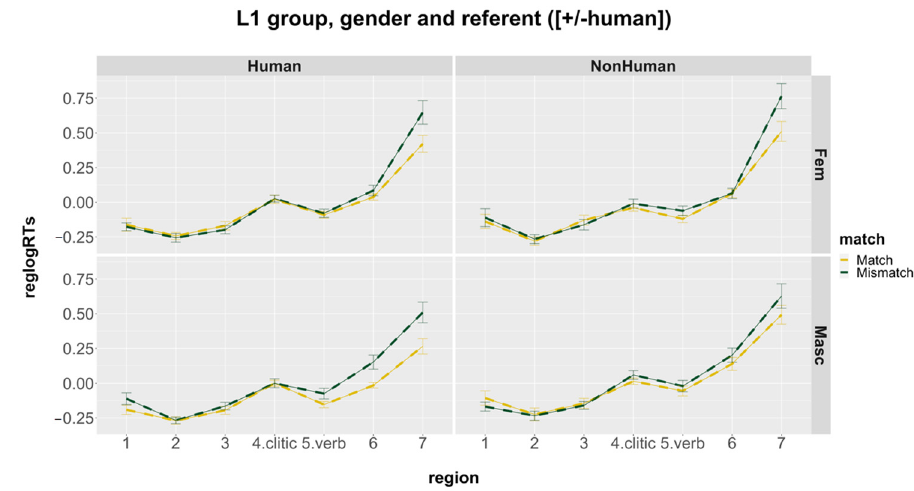
Figure 4. Length-adjusted, log-transformed reading times by region, L1 group.